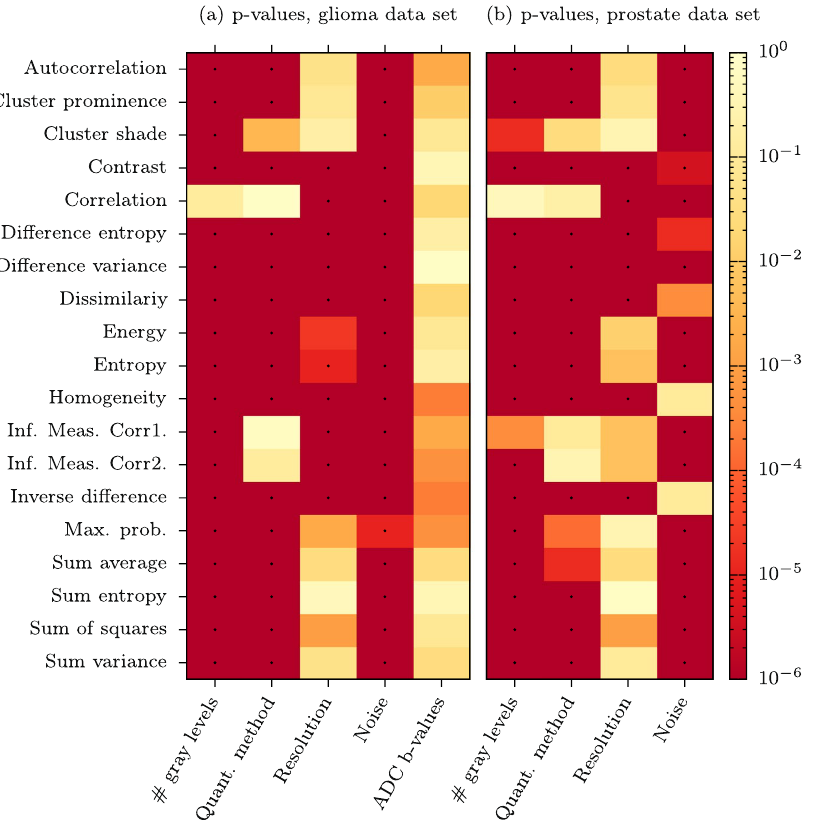
Figure 2. Probabilities that texture features are unaffected by changes in imaging or pre-processing steps. Heatmaps showing the probability (p-value) that all settings for a given parameter give the same texture feature values. The dots represent significant changes at the α = 0.01 level, with Bonferroni corrections. ( a ) Shows the result from the glioma data set, ( b ) from the prostate cancer data set.